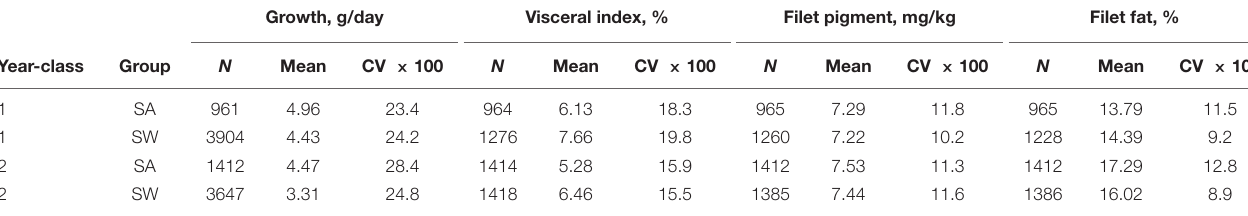
TABLE 2 | Descriptive statistics for the four studied traits of each year-class and experimental group 1 . Growth, g/day Visceral index, % Filet pigment, mg/kg Filet fat,